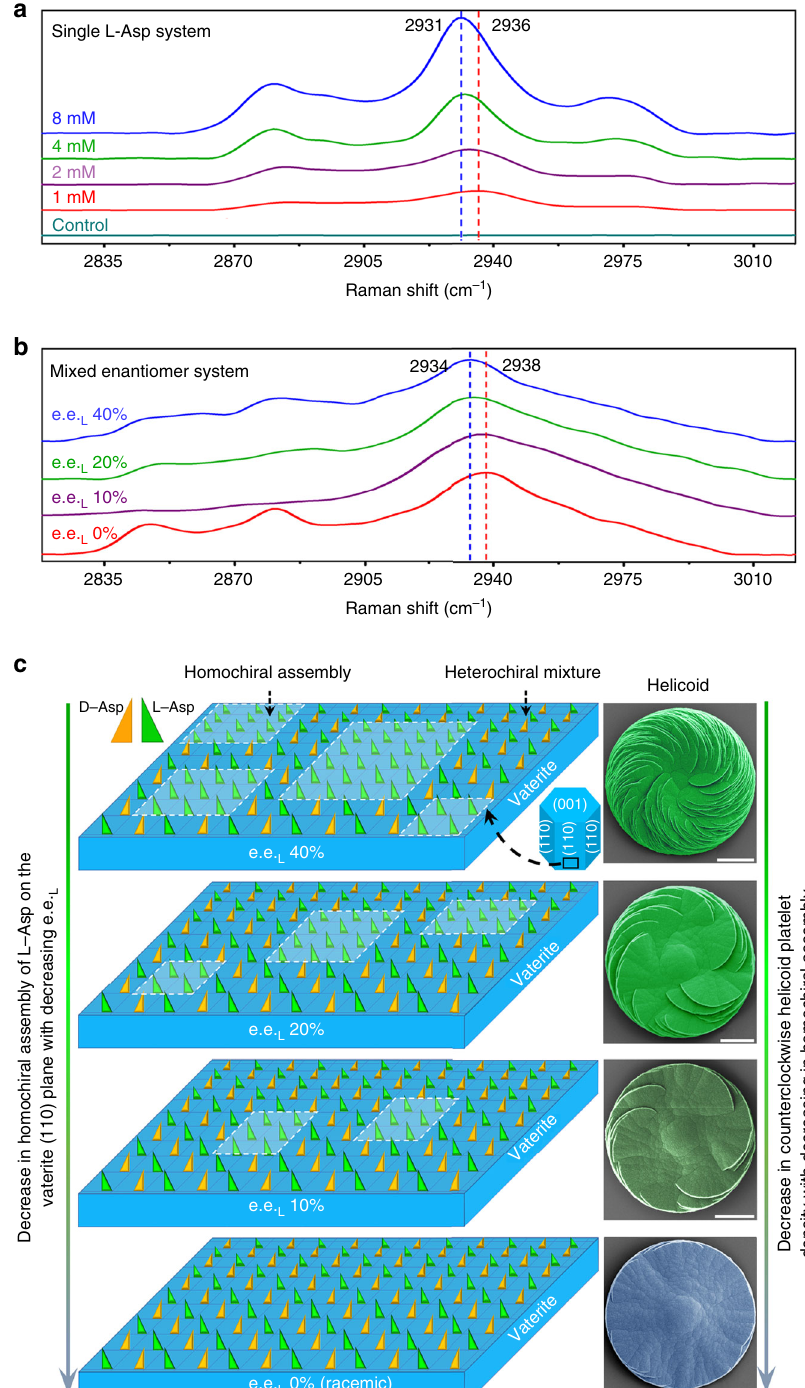
Fig. 4 Mechanism of the formation of homochiral helicoids by the assembly of incorporated amino-acid enantiomers. a Micro-Raman spectra of C-H stretching bands of vaterite helicoids formed in the presence of only L -Asp at different concentrations in supersaturated calcium carbonate solution; b micro-Raman spectra of vaterite helicoids formed in the presence of a mixture of L -and D -Asp enantiomers (total Asp concentration equals 20 m M ) at different e.e. L . All micro-Raman spectra are normalized to the ν 1 symmetric stretching peak of carbonate groups in vaterite helicoids at 1089 cm − 1 . c Schematic summary of the co-existence of heterochiral and homochiral domains on a vaterite crystal plane with spacing d = 3.6 Å, as identi fi ed by high- resolution transmission electron microscopy as shown in ref. 25 . In a nonracemic system, a decrease in enantiomeric excess of excessive L -Asp (e.e. L ) leads to a decrease in homochiral assembly, which in turn results in a decrease in counterclockwise platelet density in the vaterite helicoids (SEM imaging). In a racemic system, equal amounts of L - and D -Asp are assembled across the full surface, and no effective homochiral assembly domains are formed, and thus no chiral morphology emerges (Scale bar: 10 μ